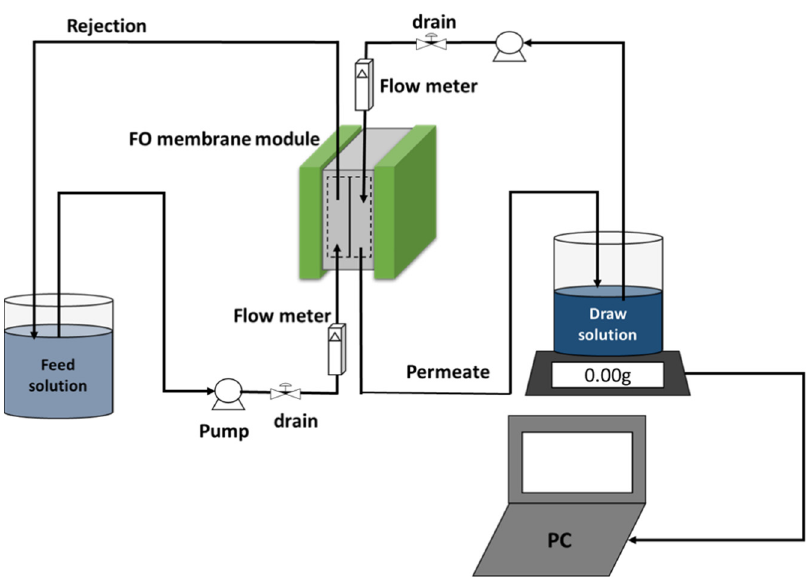
Figure 1. Forward osmosis (FO) experimental setup bench-scale.